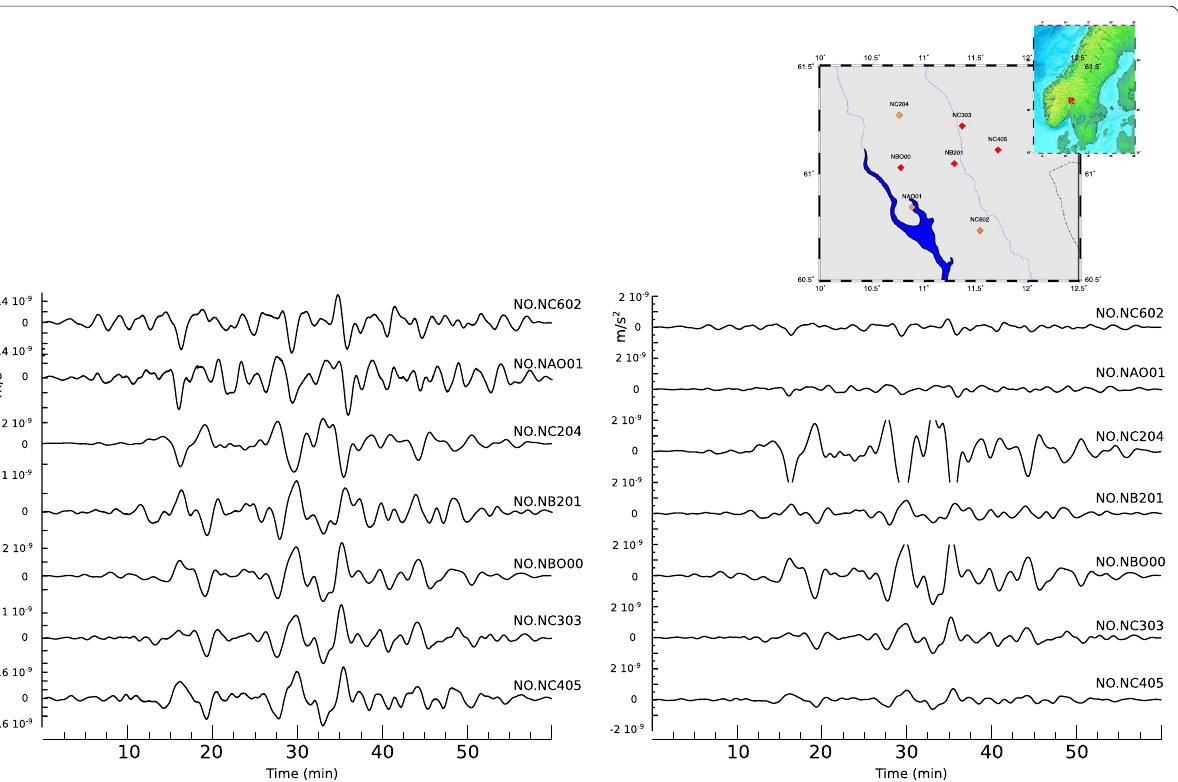
Fig. 5 Seismic records of magnetic events at high-latitude networks. Seismic acceleration recordings during the 2017/09/07 SSC event at stations of the Norsar Site array. Left panel: amplitudes normalized for each trace. Right panel: traces plotted using a common amplitude